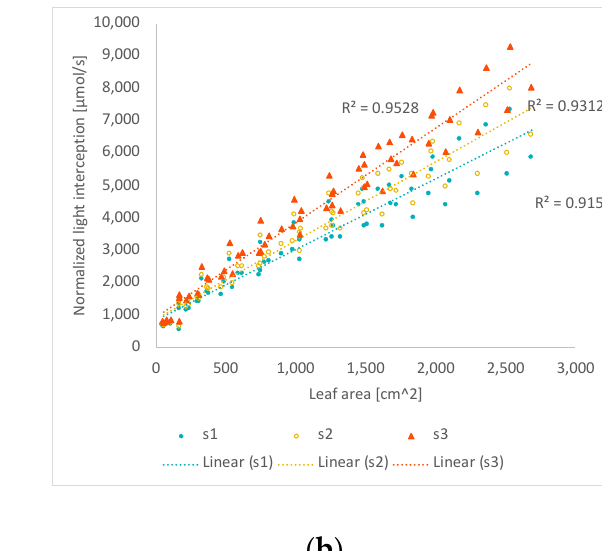
Figure 6. ( a ) Scatterplot of light interception (µmol s − 1 ) against the leaf area (cm − 2 ) for the big leaf group under different light conditions (s1, s2, and s3). ( b ) Scatterplot of normalized light interception (µmol s − 1 ) against the leaf area (cm 2 ) for the big leaf group under different light conditions (s1, s2, and s3). The light interception and leaf area were cumulated from the top of the plant to the lowest, by layers. Each scenario of light condition was fitted linearly, resulting in an R-square (R 2 ). Scenarios included s1 (27.8% of diffuse light, 426.41 µmol/m 2 s of incident PAR), s2 (48.7%of diffuse light, 336.16 µmol/m 2 s of incident PAR), and s3 (89.6%of diffuse light, 183.18 µmol/m 2 s of incident PAR).